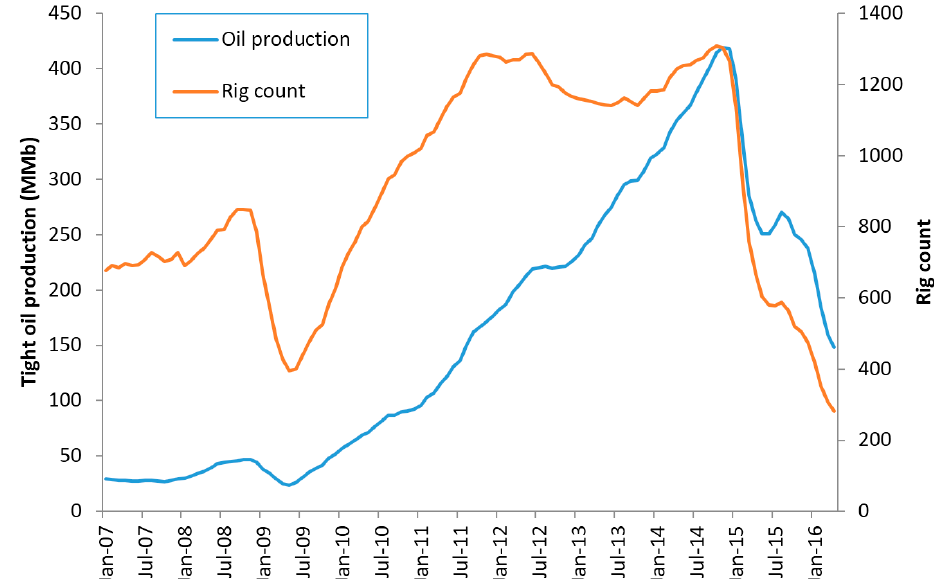
Figure 1. Monthly production and rig count in the key tight ‐ oil U.S. regions. Source: Energy Information Administration (EIA).